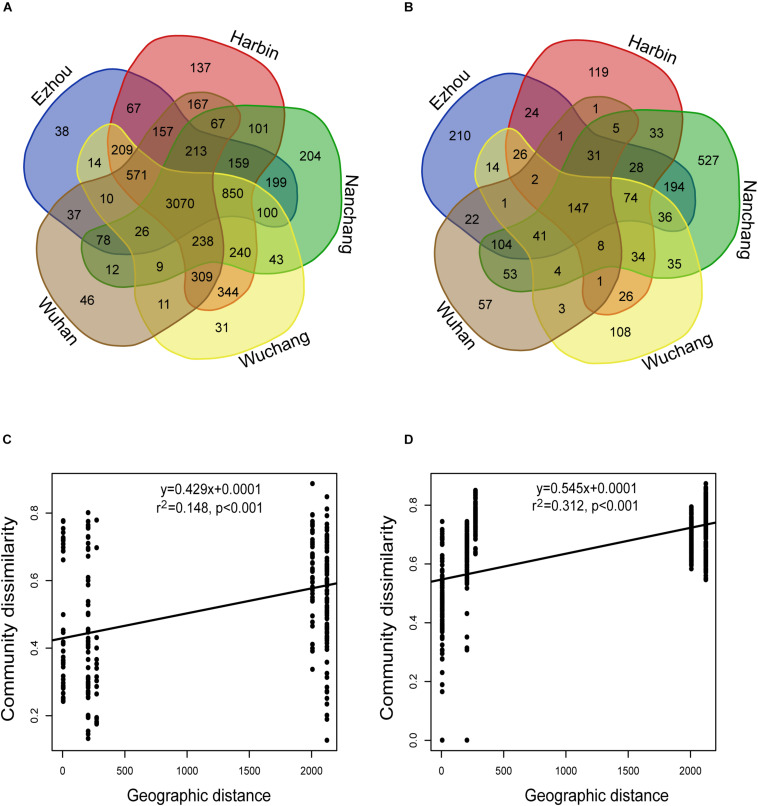
The impact of geographic location on the seed and rhizosphere bacterial communities. (A,B) The Venn diagram showing the bacterial OTUs recovered in (A) seeds, and (B) rhizosphere soils collected from different experimental sites. (C,D) The distance-decay relationships based on the Bray-Curtis distance-based community dissimilarities of the (C) seed samples: y = 0.4293x + 0.0001; r2 = 0.148; P < 0.001; and (D) rhizosphere soil samples: y = 0.545x + 0.0001; r2 = 0.312; P < 0.001.